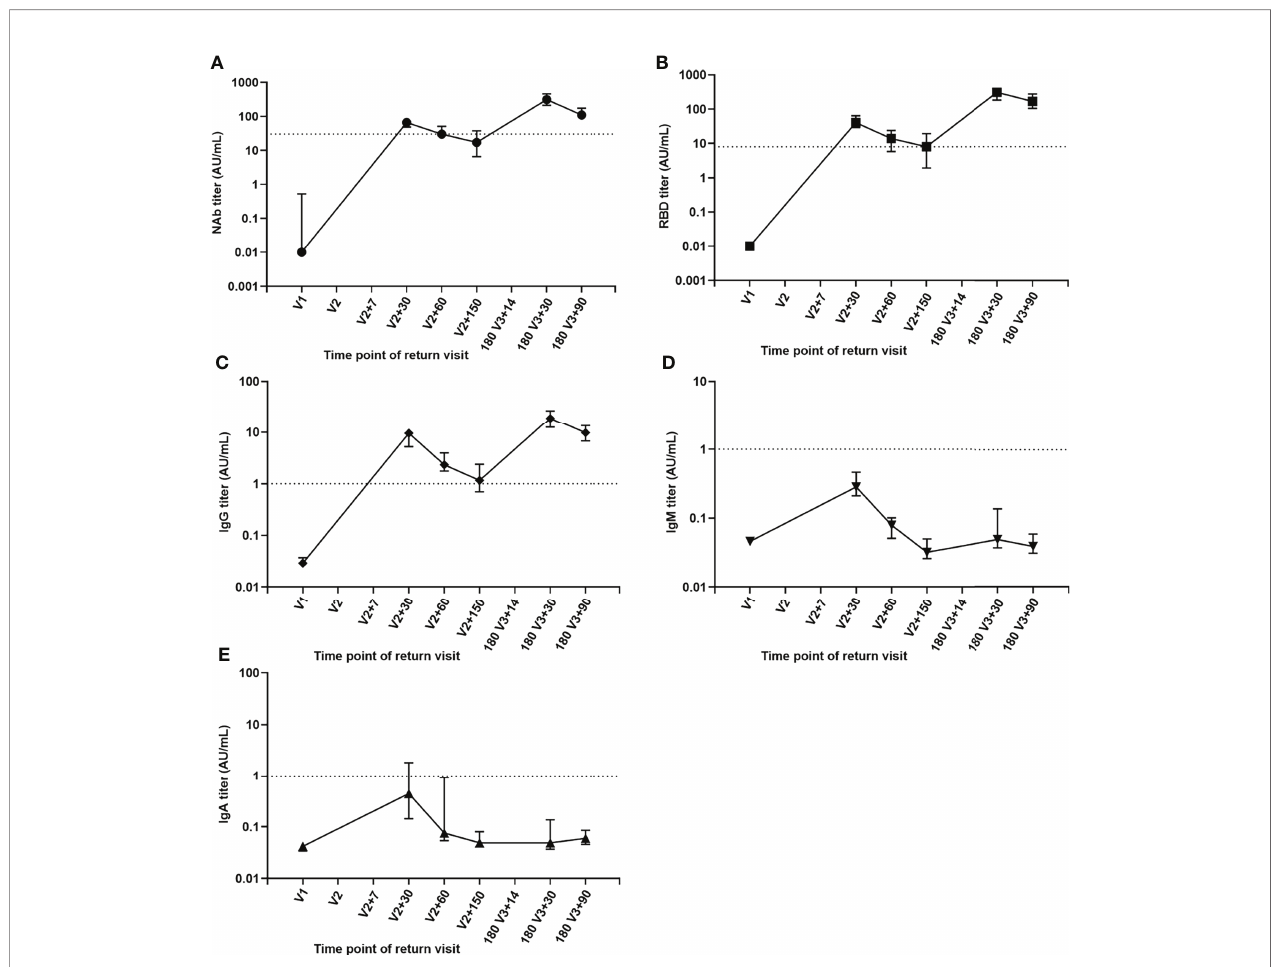
FIGURE 3 | Kinetics of antibody levels for sequential samples. (A) NAb antibody. (B) RBD antibody. (C) IgG antibody. (D) IgM antibody. (E) IgA